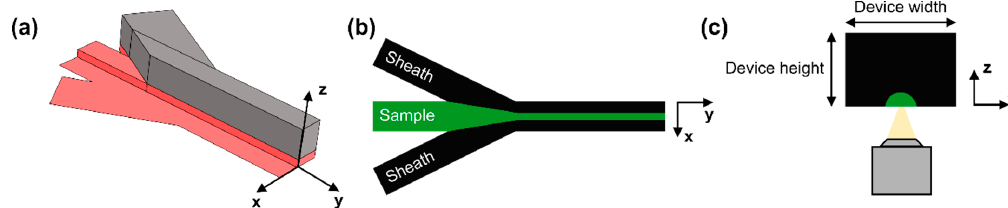
Figure 1. ( a ) Lengthwise 3D device cross-section showing the difference in height between the sheath and sample inlets. Red color is used to show the bottom layer of photoresist, and also the device footprint. The top layer of photoresist is shown in grey (mirror symmetry across the y-axis applies). The difference in height between the sheath inlet and the sample inlet shown is not drawn to scale and only serves as an example; ( b ) Device top view showing the flow focusing mechanism, where the black area is occupied by sheath fluid and the green area is occupied by the sample; ( c ) 2D lengthwise cross-section of the channel (front view) showing sample confinement from both the top and the sides.